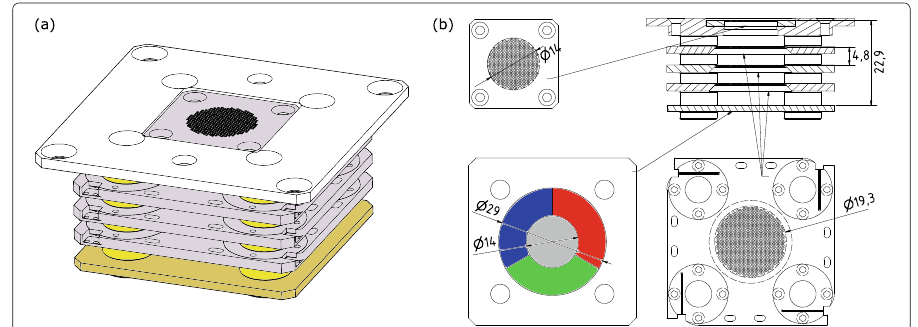
Fig. 4 The retarding potential analyzer. (a) The instrument consists of a stack of four titanium grids and a collector plate. (b) The construction drawings show details of the geometry. Note the segmented collector with a central area (gray) and three outer ring segments (colored). The remaining surface of the collector plate (white) is also covered with a conductive layer and grounded. The individual segments are insulated from each other by a narrow